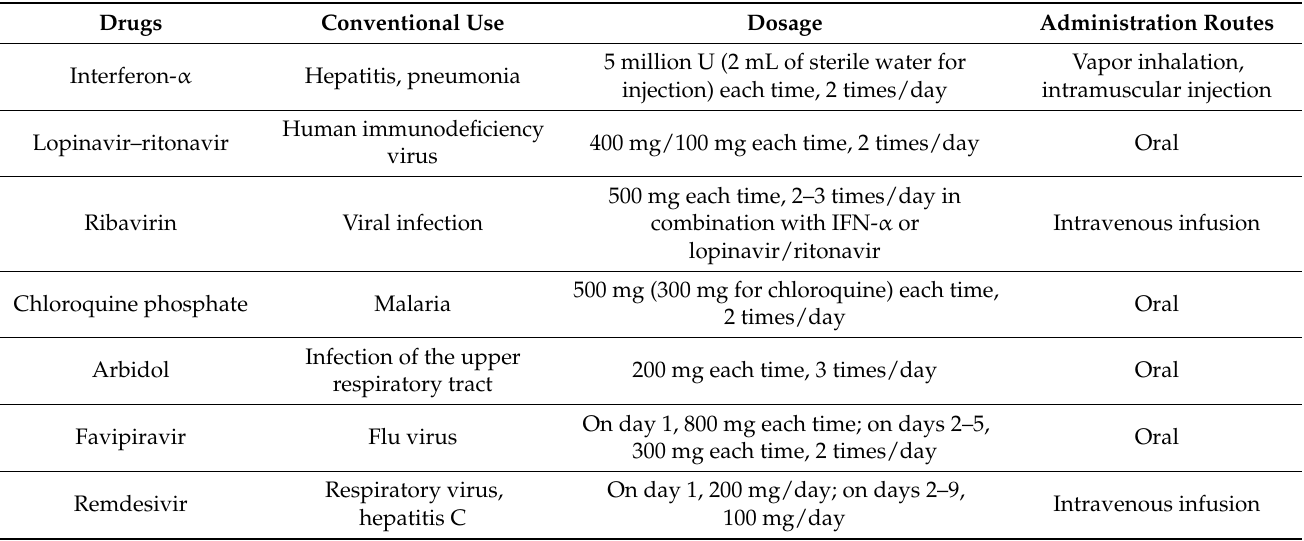
Table 1. Approved drugs with anti-COVID-19 viral